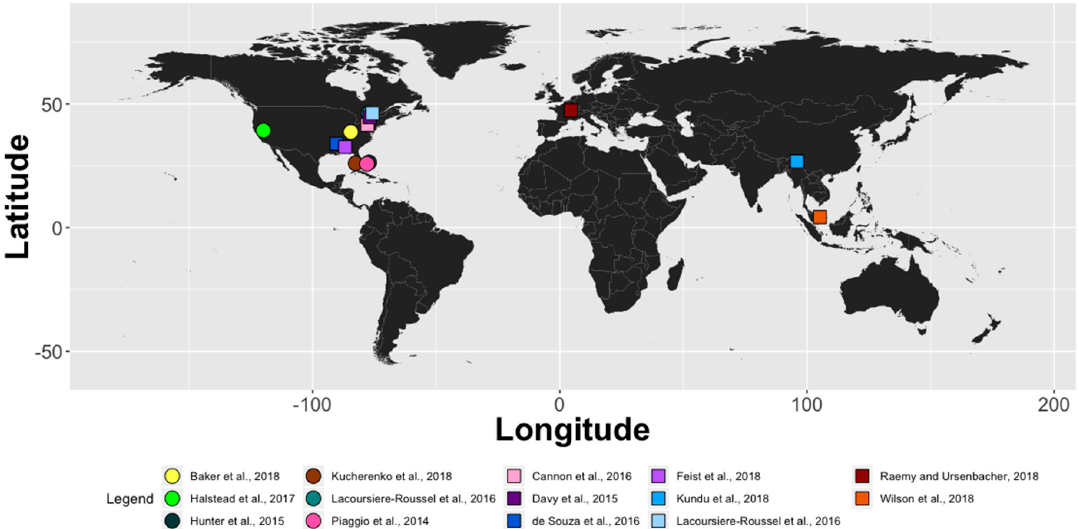
Figure 1. A global map of non-avian reptile studies using eDNA and metabarcoding methods mentioned in this paper. Each color denotes a different study. Circles indicate snake studies and triangles indicate turtle studies. Note that one study by Lacoursière-Roussel et al., 2016 [70], found both snakes and turtles. Antarctica not pictured.